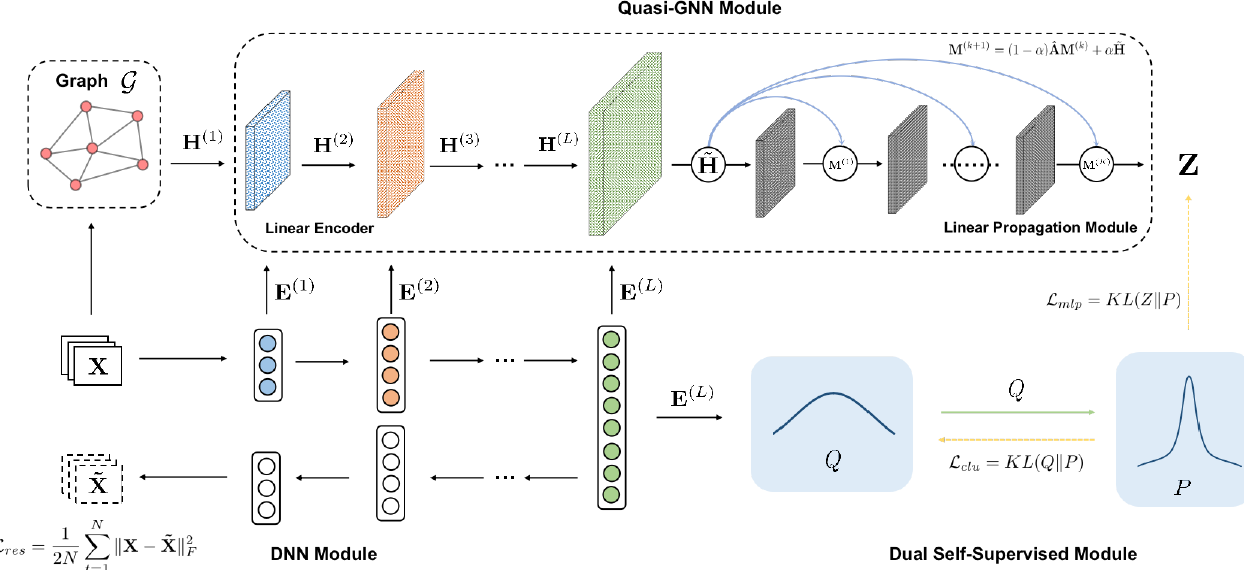
Figure 1. The overall framework of SDN is as above. X , ˜X are input data and reconstructed data, respectively. E ( l ) and H ( l ) are the results of the l -th layer of the linear encoder in the DNN and Quasi- GNN modules, respectively. Layers with different colors represent E ( l ) of different embeddings learned by the DNN module. The green solid line indicates that the target distribution P is calculated by the distribution Q , the yellow dotted line represents the dual self-supervision mechanism, and the target distribution P supervises the training of the DNN module and the Quasi-GNN module at the same time. The solid blue line in the linear propagation layer of the Quasi-GNN module represents the propagation